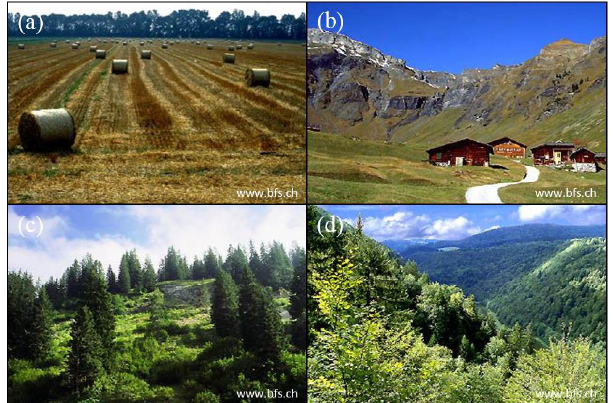
Figure 2. Examples of (a) intensively used open land (b) exten- sively used open land (c) open forest (d) closed